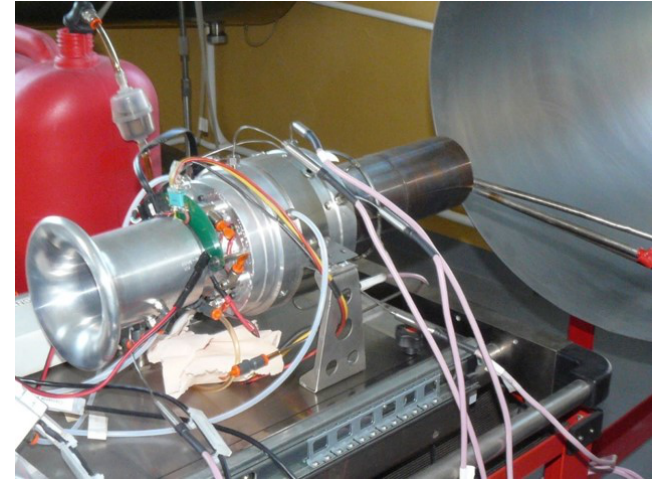
Figure 2. GTM-140 microturbine.